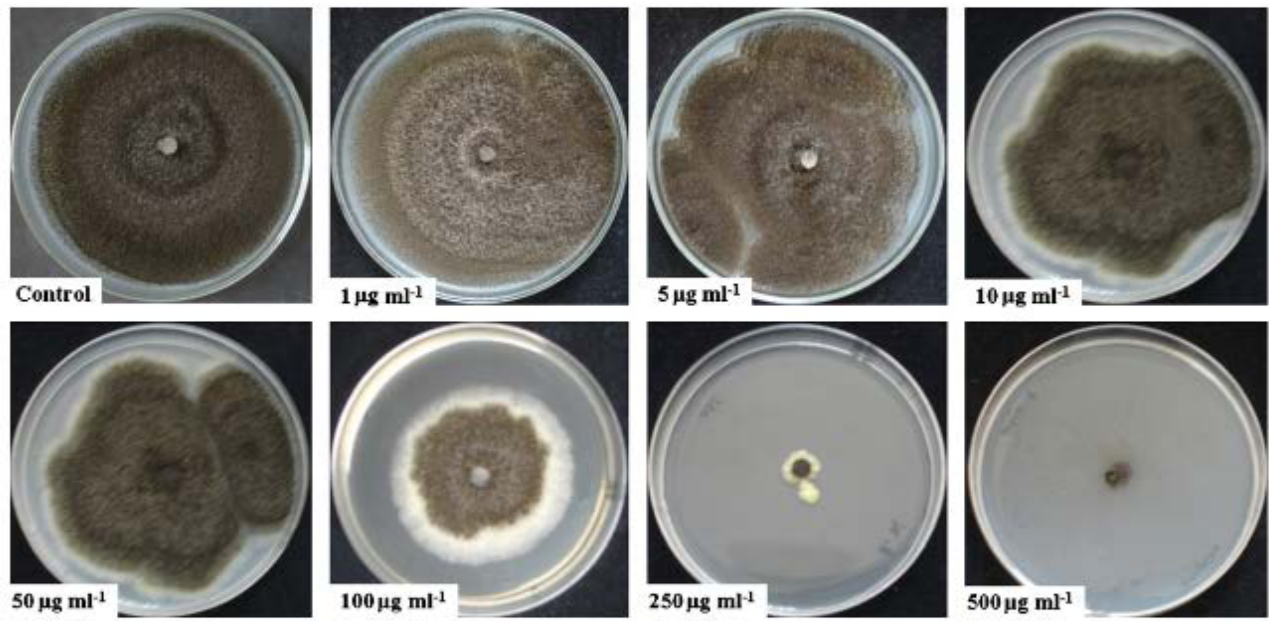
Figure 5. A. niger fungi growth in rGO dispersions with different concentrations (0–500 µ g/mL) after 7-day incubation. Reprinted from [81] with permission from Elsevier.